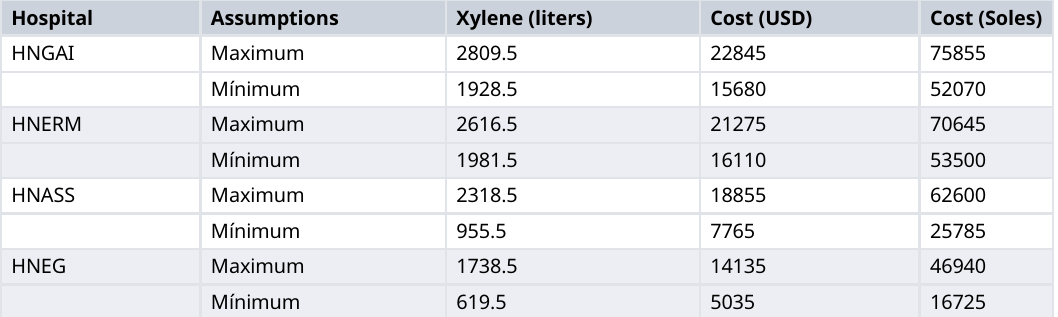
Table 2. Quantity and, maximum and minimum costs and liters of xylene. We describe the quantities and, maximum and minimum costs estimated in this study at four EsSalud hospitals during 2015 – 2019 in Lima, Peru.